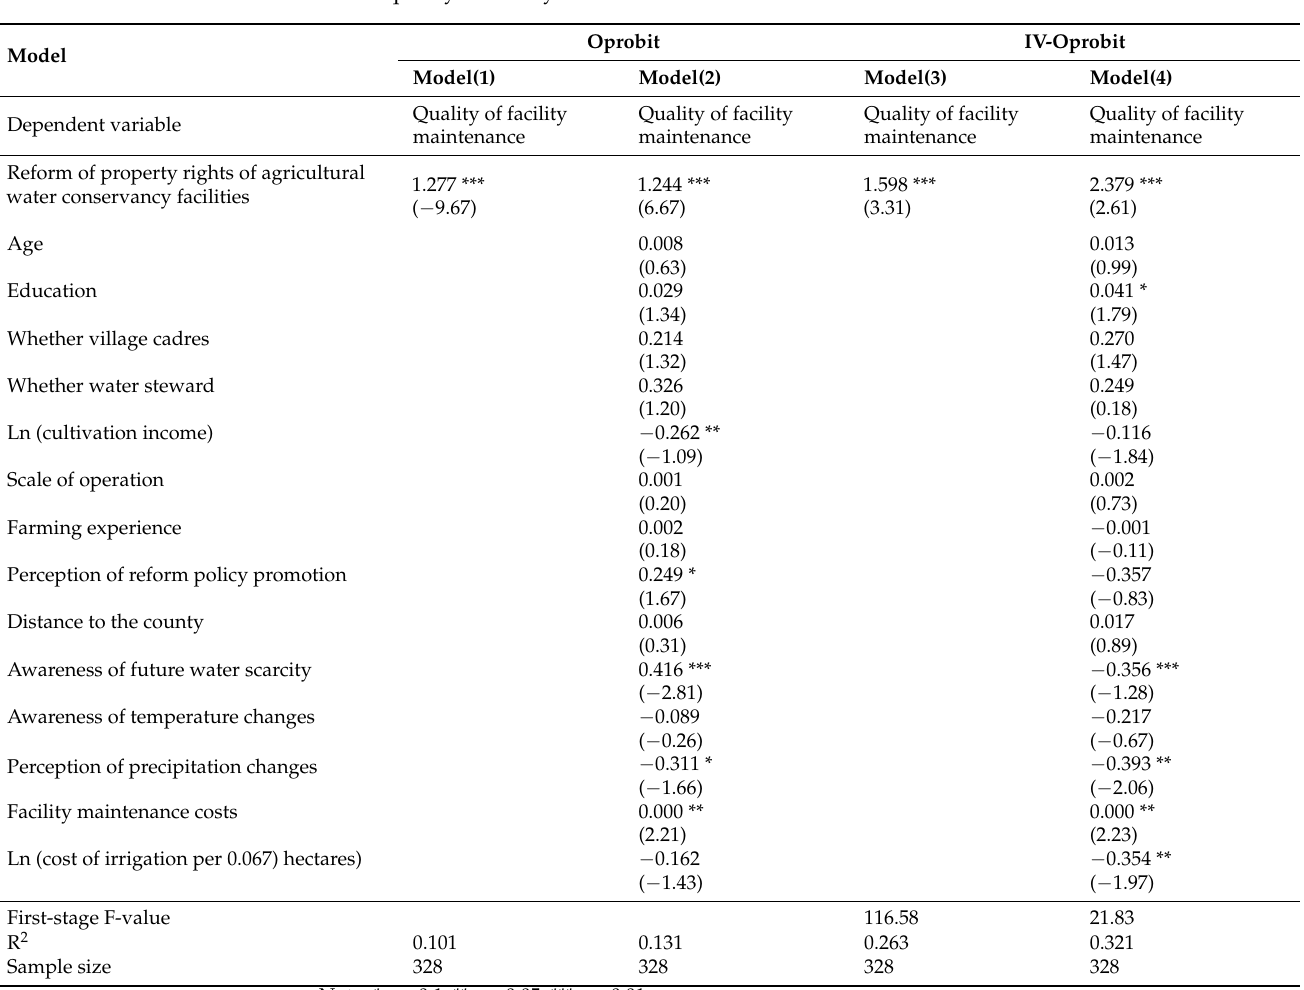
Table 3. Regression results of the impact of the reform of property rights of agricultural water facilities on the quality of facility maintenance.